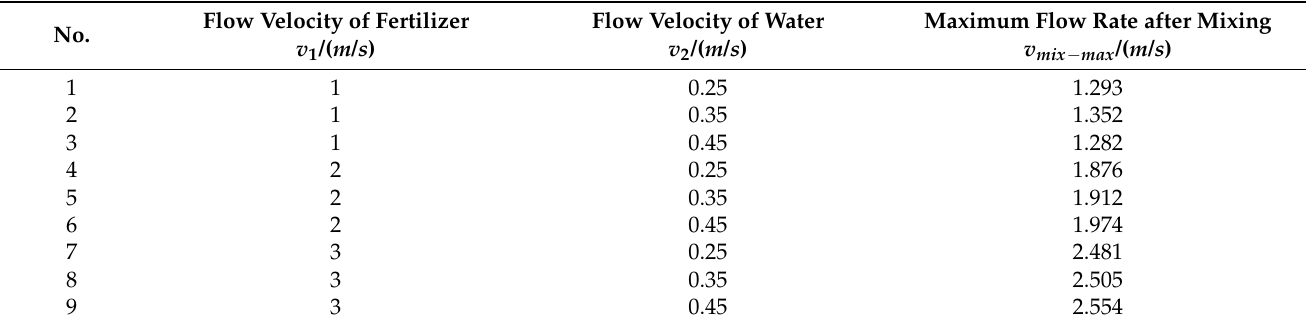
Figure 10. Volume fraction of fertilizer for different water and fertilizer flow rates. ( a ) No.1–No.3, ( b ) No.4–No.6, ( c ) No.7–No.9. Table 3. Flow rate variation for the numerical simulation.